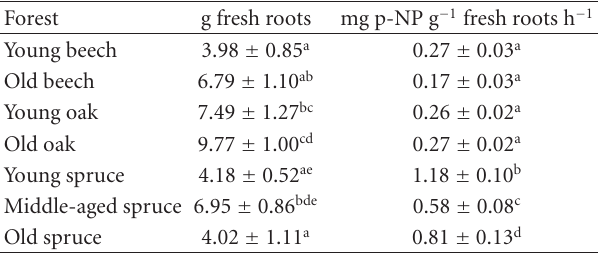
Table 1: Total Root Mass and EAPM Activity of Roots in Seven Forest Stands (Mean ± SE). Di ff erent Letters Mark Significant Di ff erences ( P < 0 .